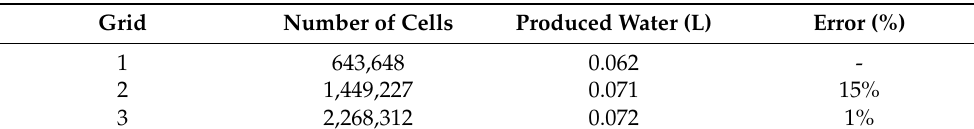
Table 5. Grid independence test.